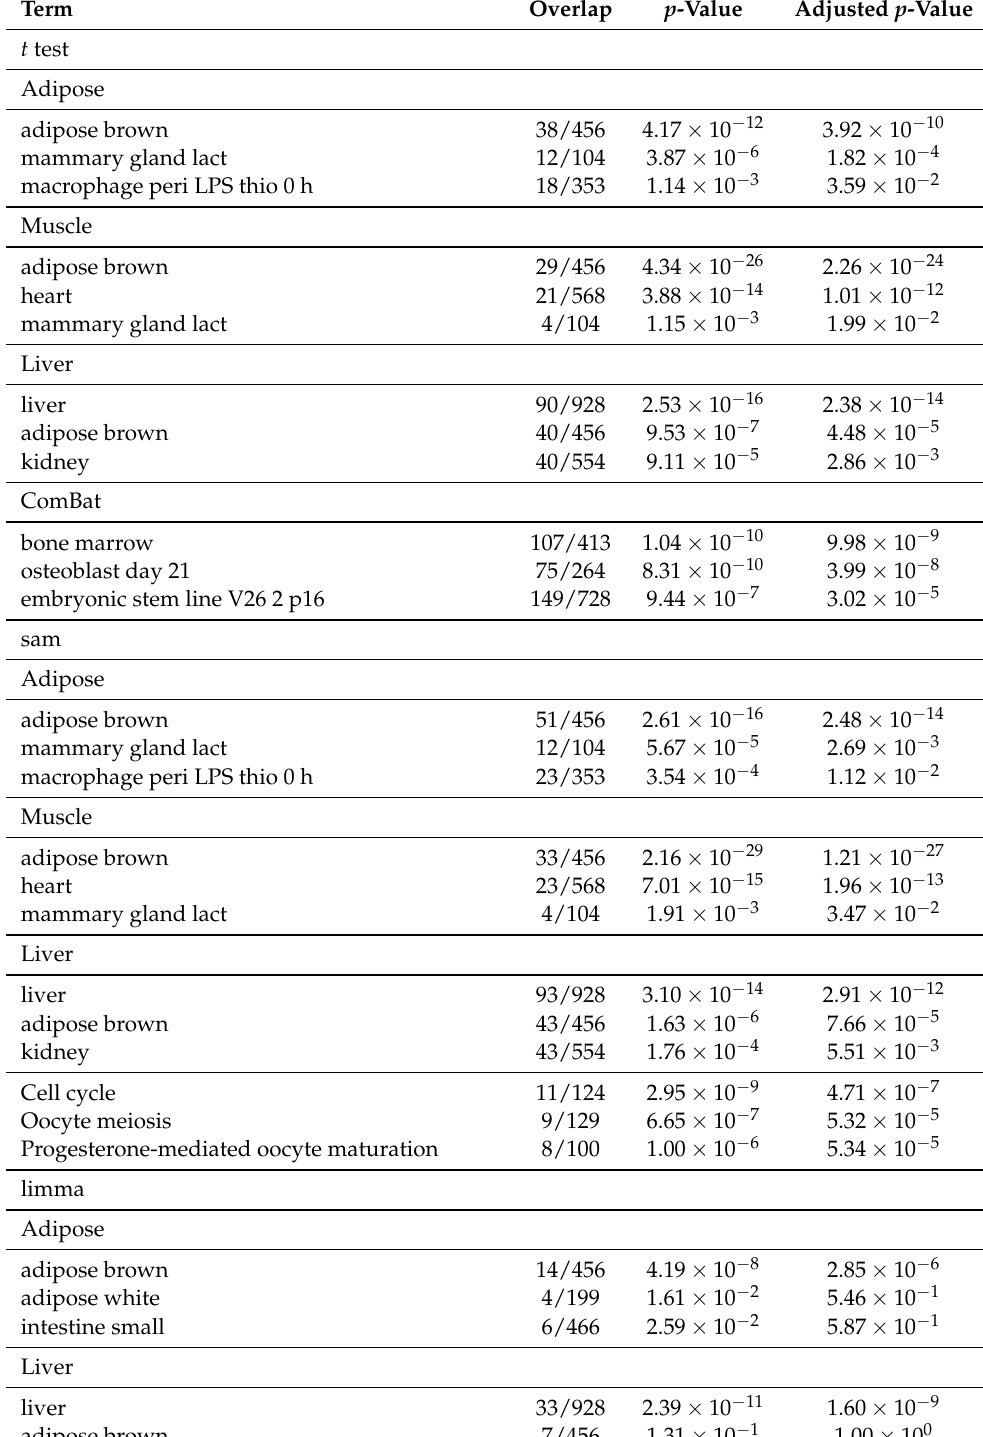
Table 5. Top three terms by other methods in the “Mouse Gene Atlas” category in Enrichr.